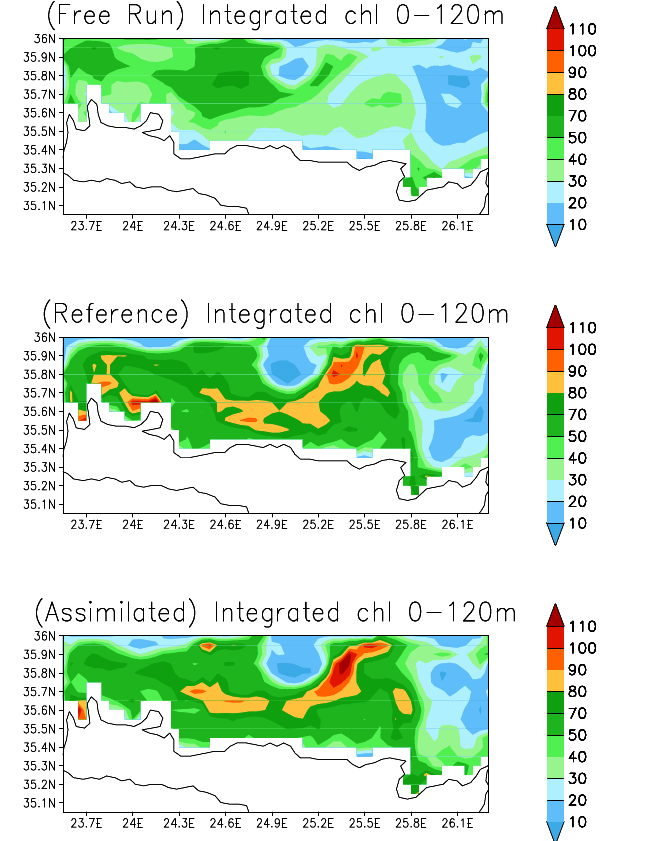
Fig. 10. Integrated bacterial biomass between 0m–120m from the free run, the reference run, as estimated by the SEPLEK